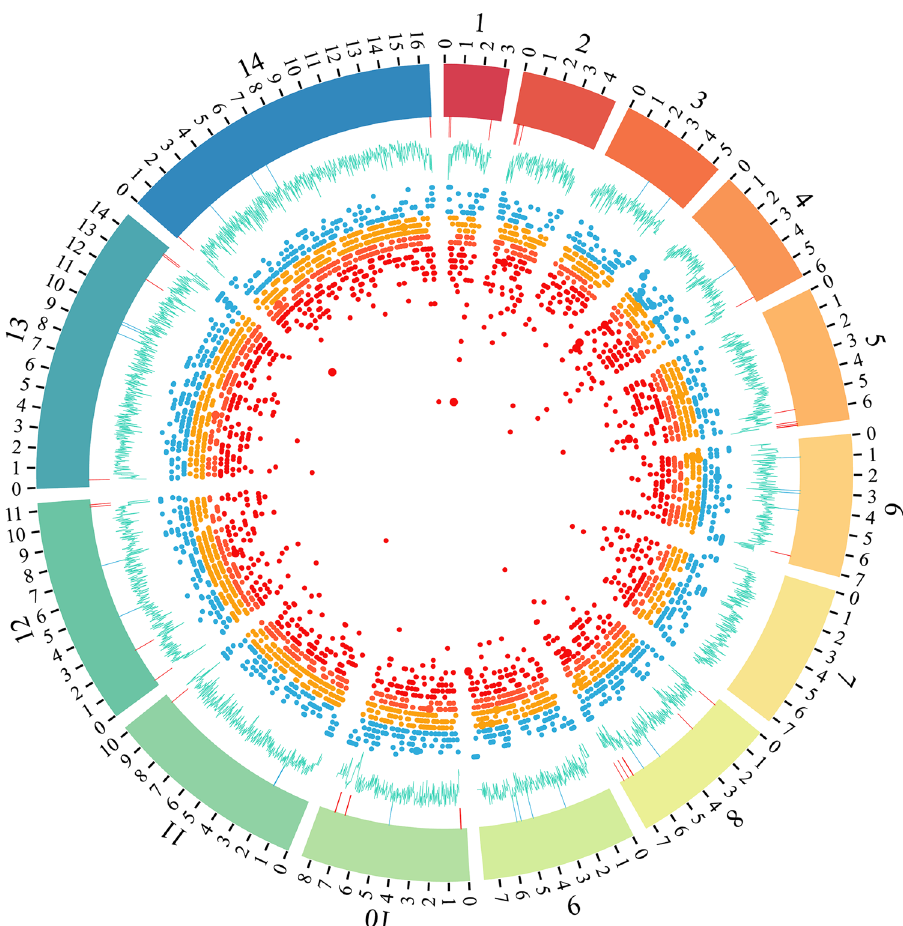
Figure 2. Genomic wide scans of SNP density and Tajima’s D. The figure shows SNP density in quartiles (blue, orange, red and dark red) across the 14 P. falciparum chromosomes (internal dot plot) showing regions with high density on chromosomes 1, 2, 4, 5, 7, 8, 11, 13 and 14. Population scaled Tajima’s D shows regions under positive selection on chromosomes 1–6, 8, 10–14 (external blue line plot). Coordinates of genes under positive (red) or negative (blue) selection are shown as lines after the Tajimas’D line